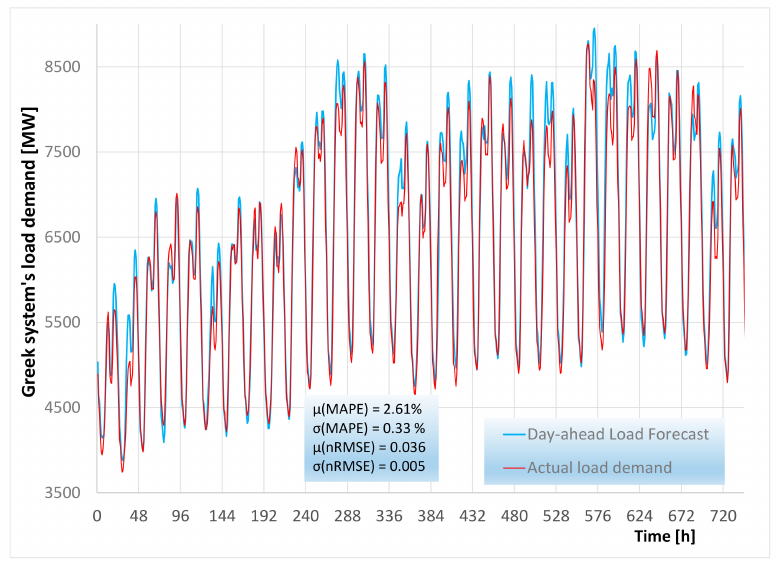
Figure 1. Greek system load during January 2022, day-ahead predicted versus actual values (MW)